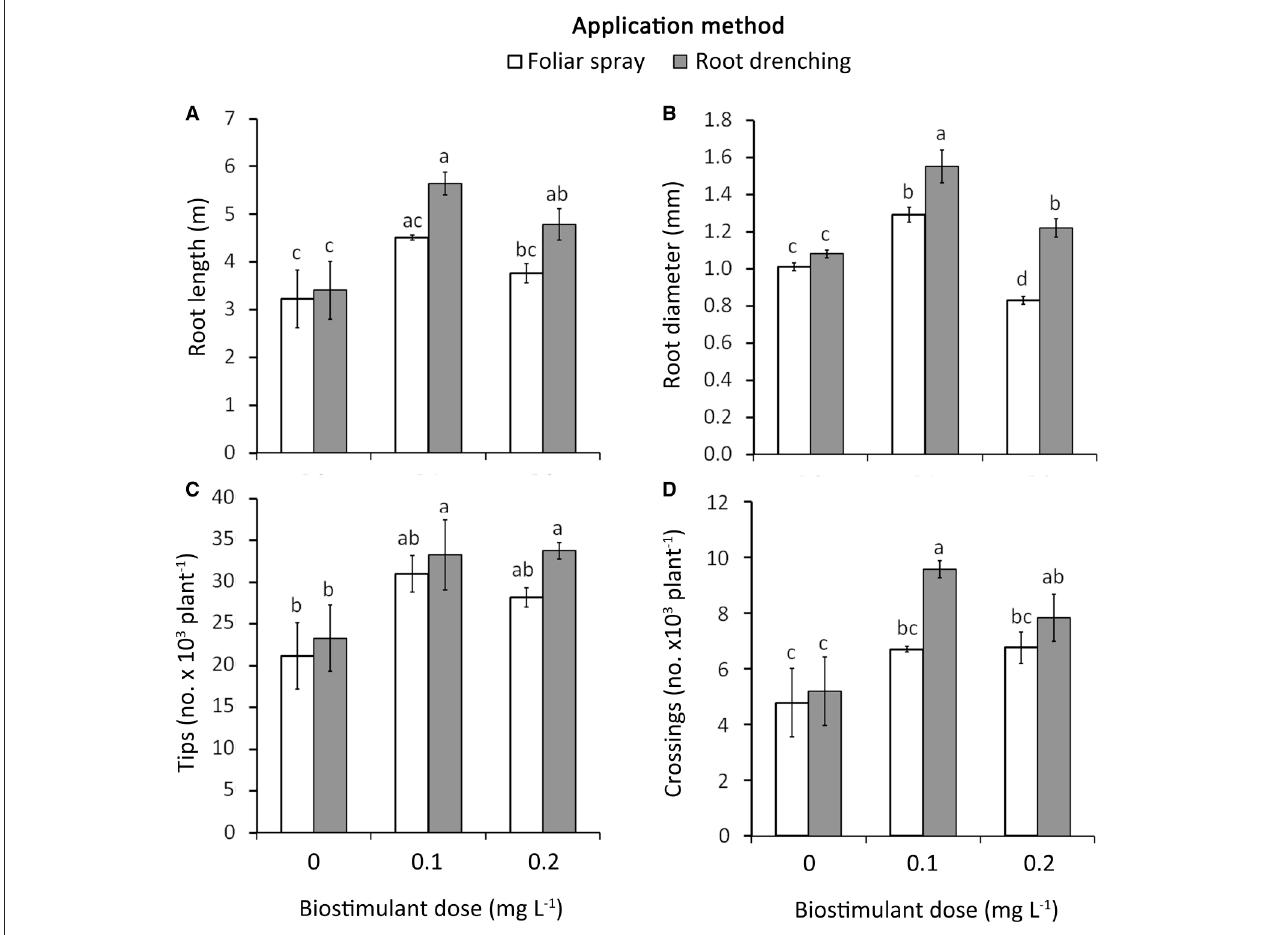
FIGURE 1 | Effect of biostimulant dose (D 0 , D 0.1, and D 0.2) and application method (F, foliar spray; R, root drenching) on root length (A) , root diameter (B) , tip number (C) , and crossing number (D) at the end of the experiment (166 DAT). Vertical bars (standard error) ( n = 6) with different letters are significantly different according to Duncan’s test ( P =